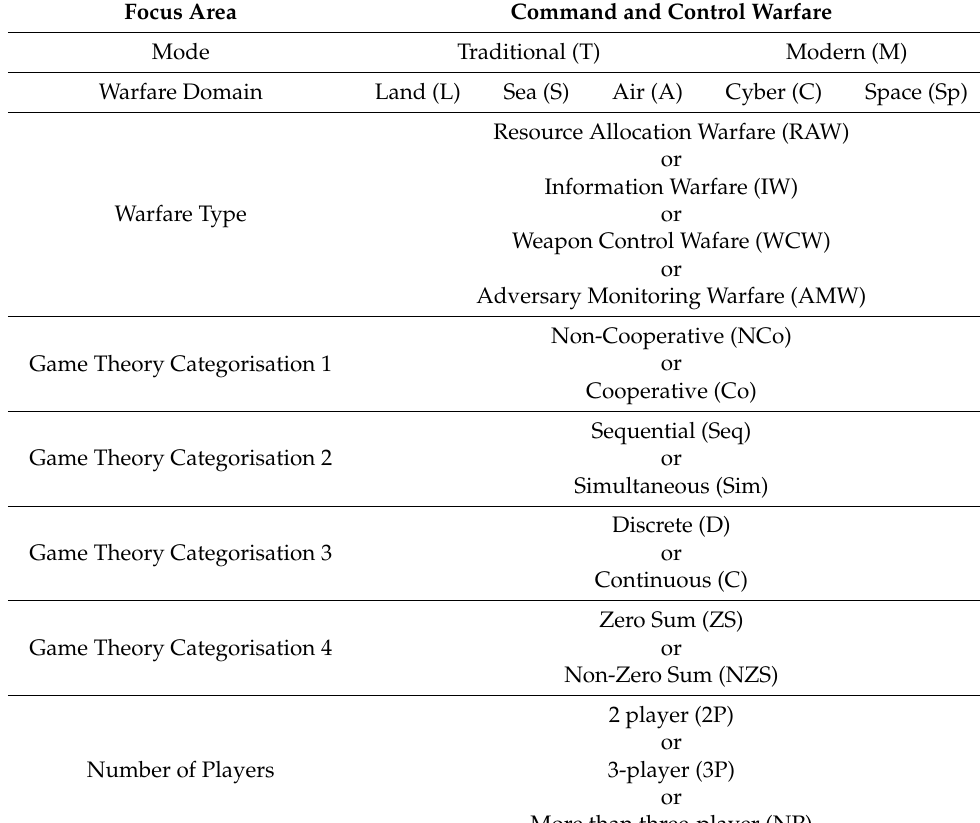
Table 1. Classification System used in this review. Focus Area Command and Control Warfare Mode Traditional (T) Modern